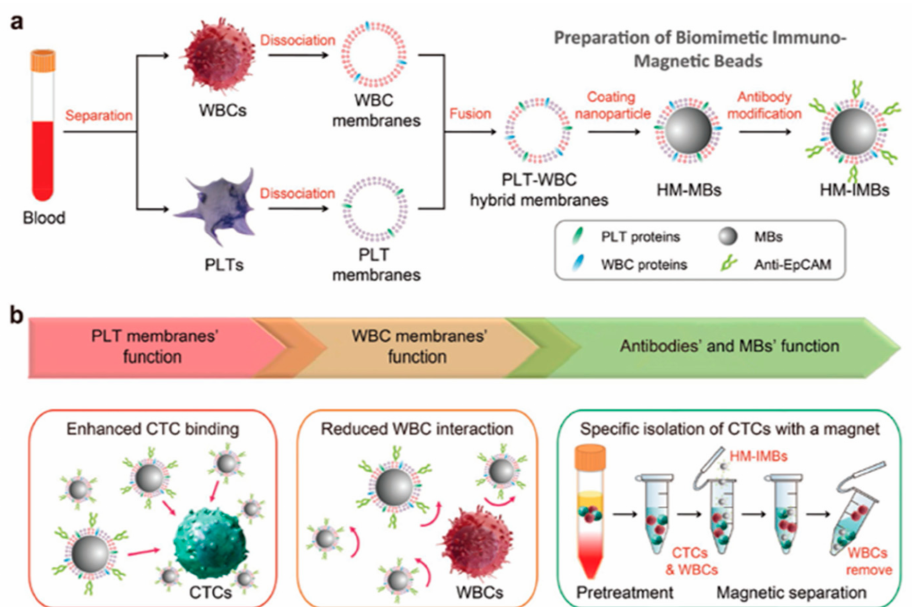
Figure 4. Schematic illustration of membrane-coated immunomagnetic beads (HM-IMBs). ( a ) Membrane isolated by WBC and PLT were utilized to coat the magnetic beads (MBs). ( b ) Membrane- coated immunomagnetic beads improved the binding of circulating tumoral cells (CTSs) from PLTs and abridged the homologous interaction with WBCs. Reproduced with permission from Ref.